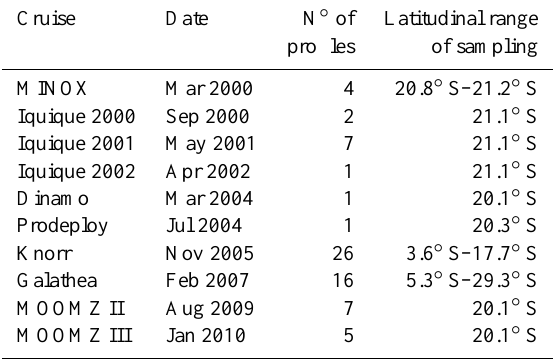
Table 1. Number of N 2 O profiles and locations of cruises included in the